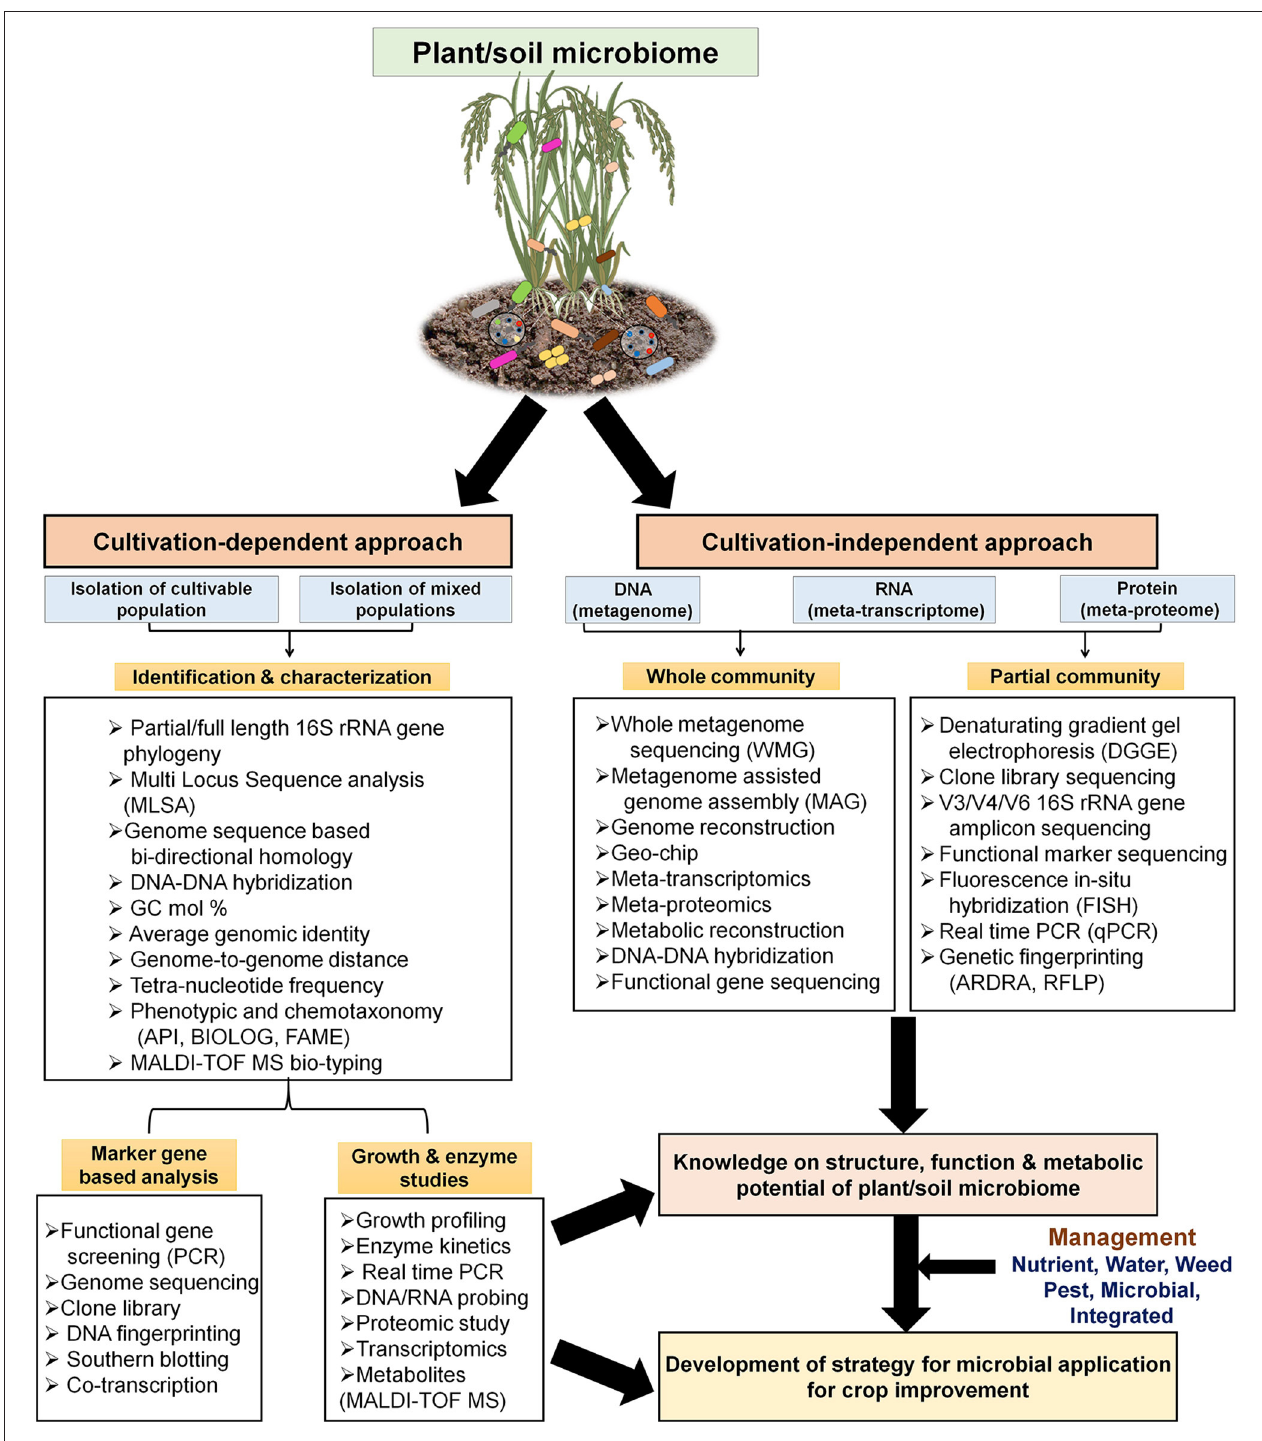
FIGURE 3 | Use of cultivation-dependent and –independent (metagenomics, other OMICS) approaches for studying PGP microbial ecology, physiology, and biochemical functions at genetic and molecular levels. The steps and workflow are depicted for better understanding of structure-function of soil PGP microbiome together with application of various management strategies for sustainable crop